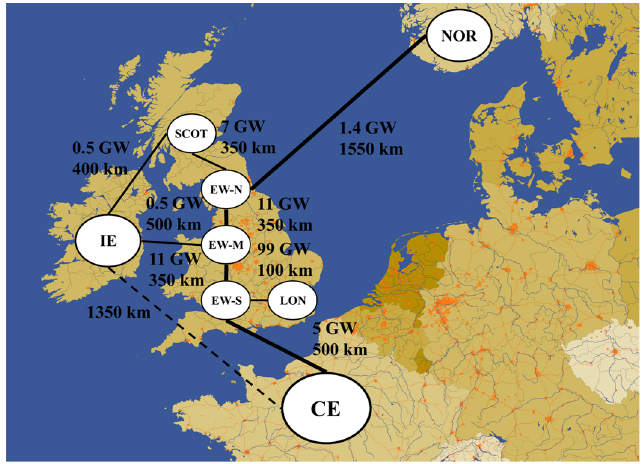
Figure 2. The simplified topology of the interconnected GB system.